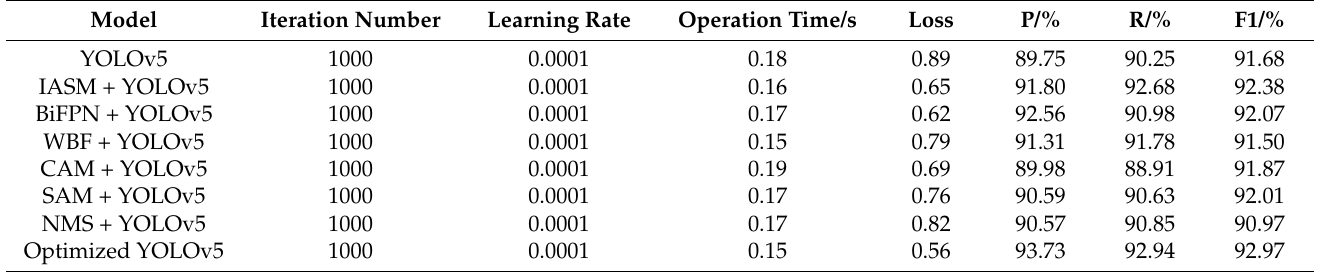
Table 6. The results of the ablation experiment (the improved methods proposed in this study and other similar methods are added to the model, respectively).